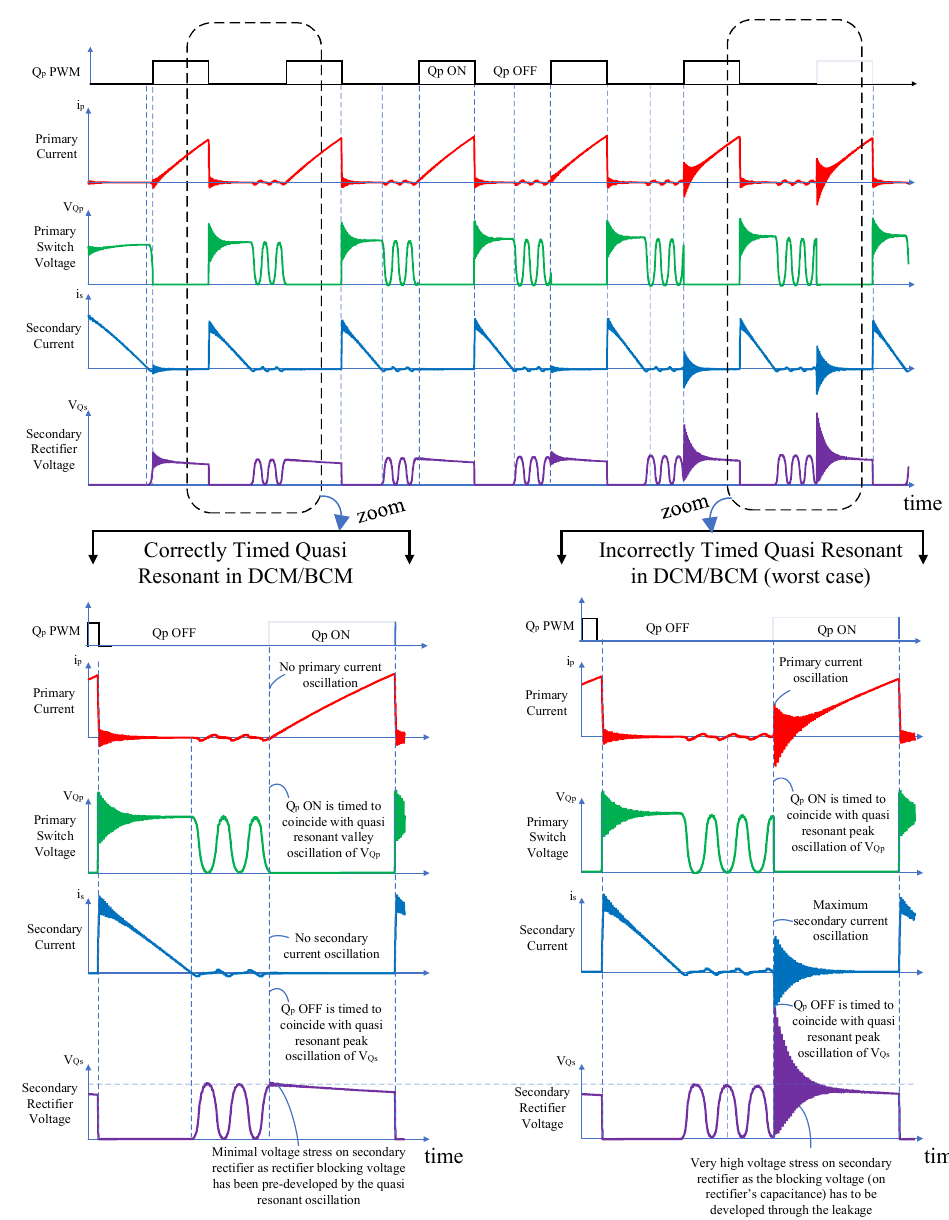
Figure 4. Quasi-resonant as a solution to the rectifier problem is only possible in DCM and BCM.